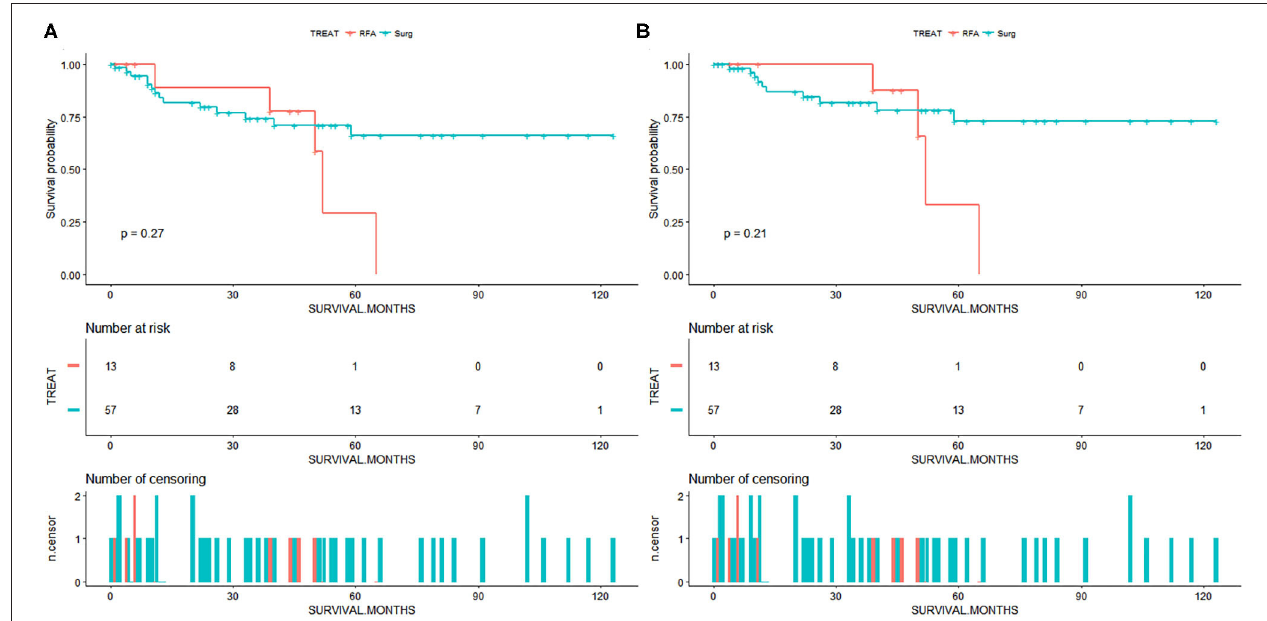
FIGURE 3 | (A) Overall survival for patients with intrahepatic cholangiocarcinoma of tumor size < 3 cm. (B) Cancer-specific survival for patients with intrahepatic cholangiocarcinoma of tumor size < 3 cm. Surg, surgical resection; RFA, radiofrequency